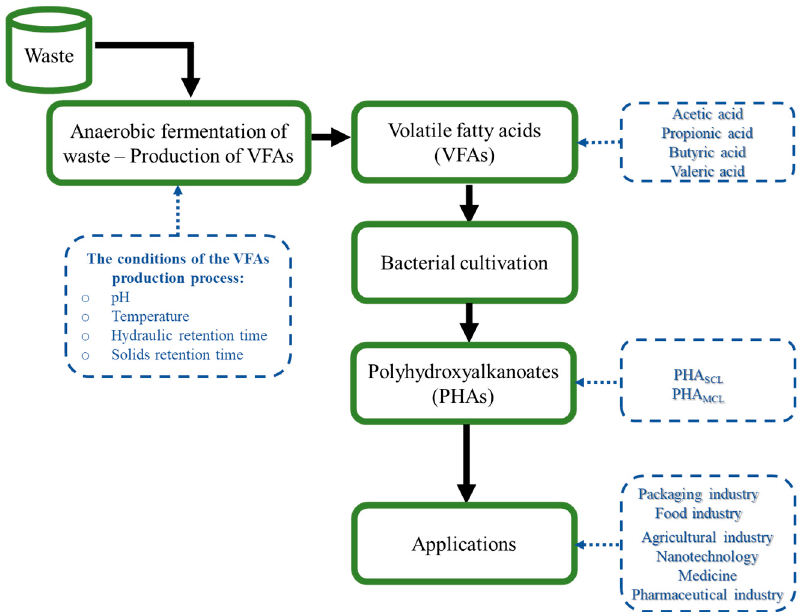
Figure 2. PHAs process value chain using volatile fatty acids. Many reports show that VFAs could be good carbon sources for PHA